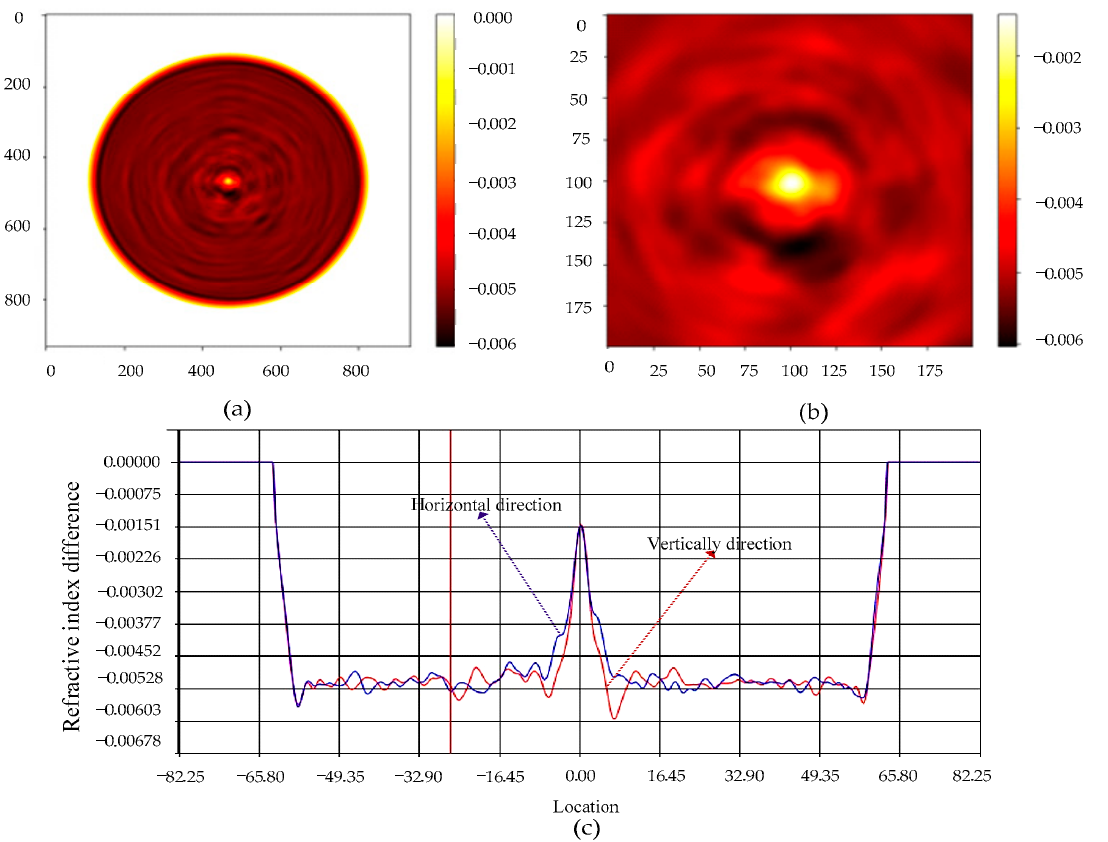
Figure 2. New fiber parameters, ( a ) Optical fiber cross-section refractive index profile; ( b ) Fiber Core Refractive Index Profile; ( c ) Refractive index difference in horizontal direction and in vertical direc- tion of optical fiber.